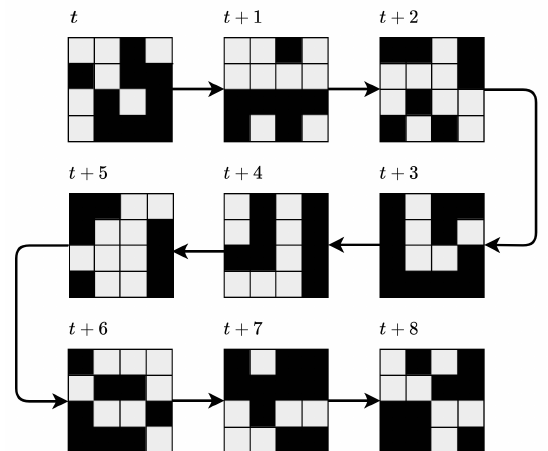
Figure 17. A pattern produced with nine cycles of the global update circuit shown in Figure 16. All cells started with | 0 (cid:105)